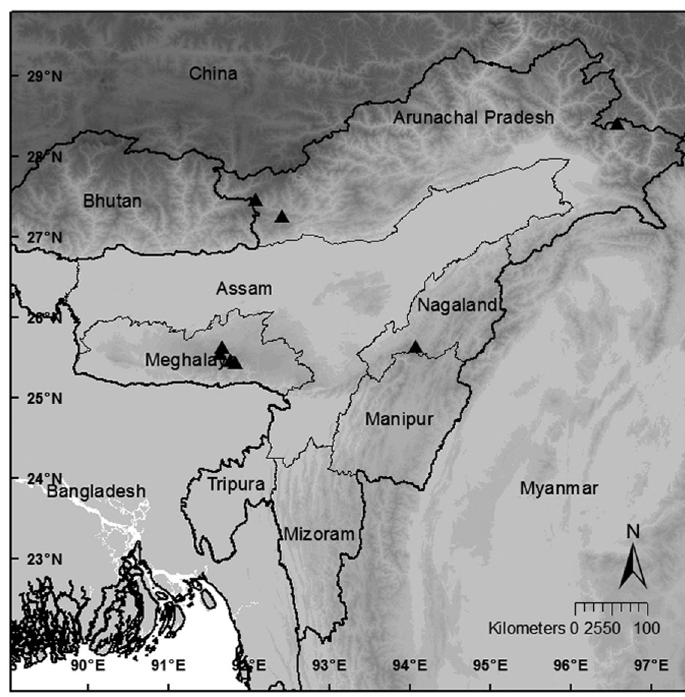
Fig. 31. Map showing the location of B. josephi A.DC.